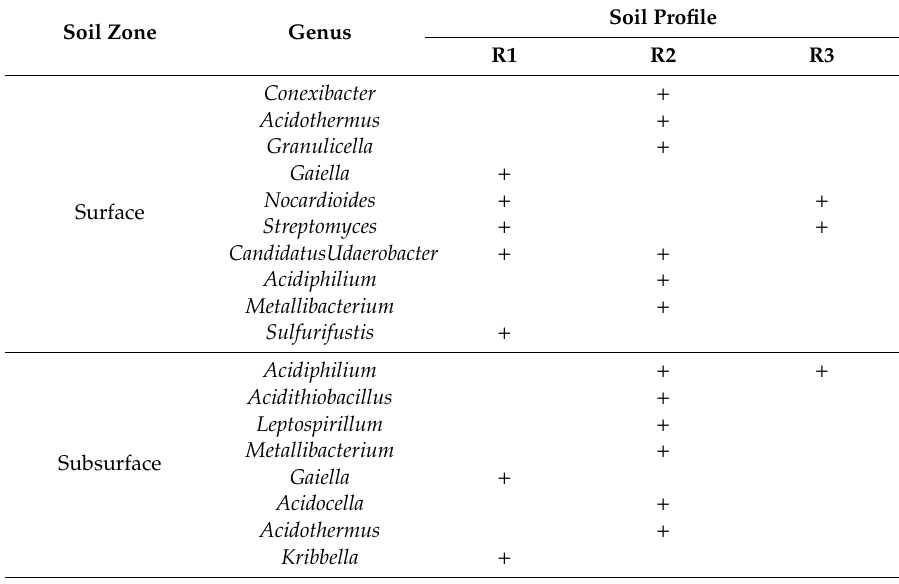
Table 1. Variability of the top bacterial genera (with abundance above 10% of all sequences) detected in the studied soil profiles (+ means the presence of the genus, − means the absence of the genus).